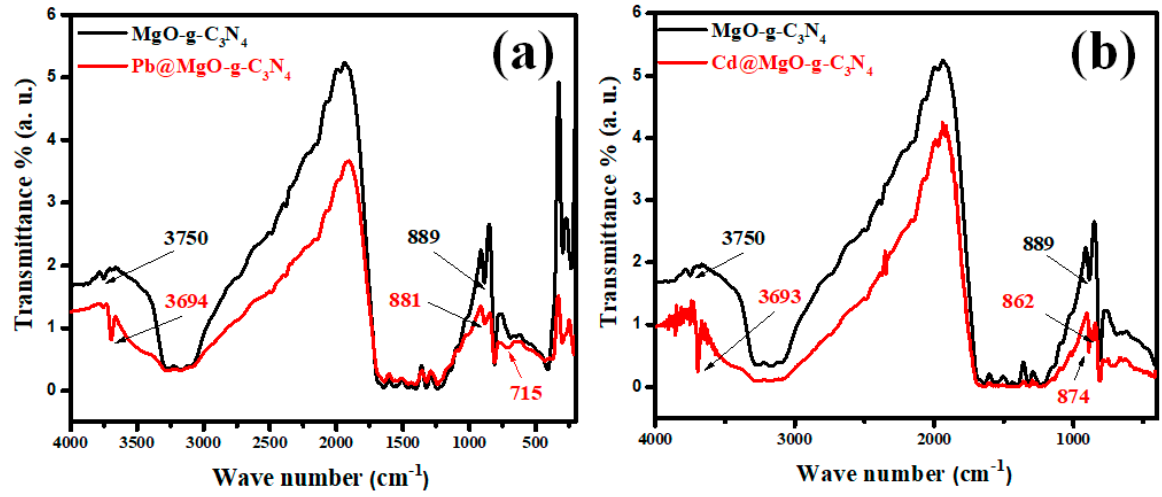
Figure 11. FTIR spectra of MGCN sorbent before and after adsorption of ( a ) Pb ++ and ( b ) Cd ++ . Moreover, the peak at 889 cm − 1 ascribed triazine ring (C 3 N 3 ) mode also slightly shifted to 881 cm − 1 for Pb ++ and 874 cm − 1 for Cd ++ . The π delocalized electron of the tri-s-triazine ring (C 3 N 3 ) acts as Lewis’s base, as mentioned by Xiao et al., while the metal ions act as Lewis’s acid [41]. Accordingly, the electrostatic interaction involved during adsorption of